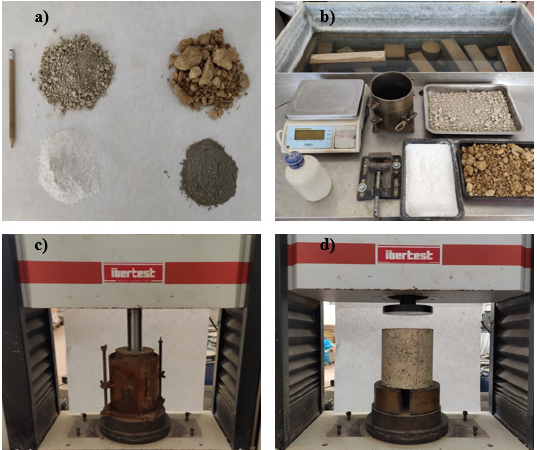
Figure 6. Experimental methods and materials photographs. ( a ) Soils and binders. ( b ) Modified Proctor test. ( c ) CBR index test. ( d ) Unconfined compressive strength